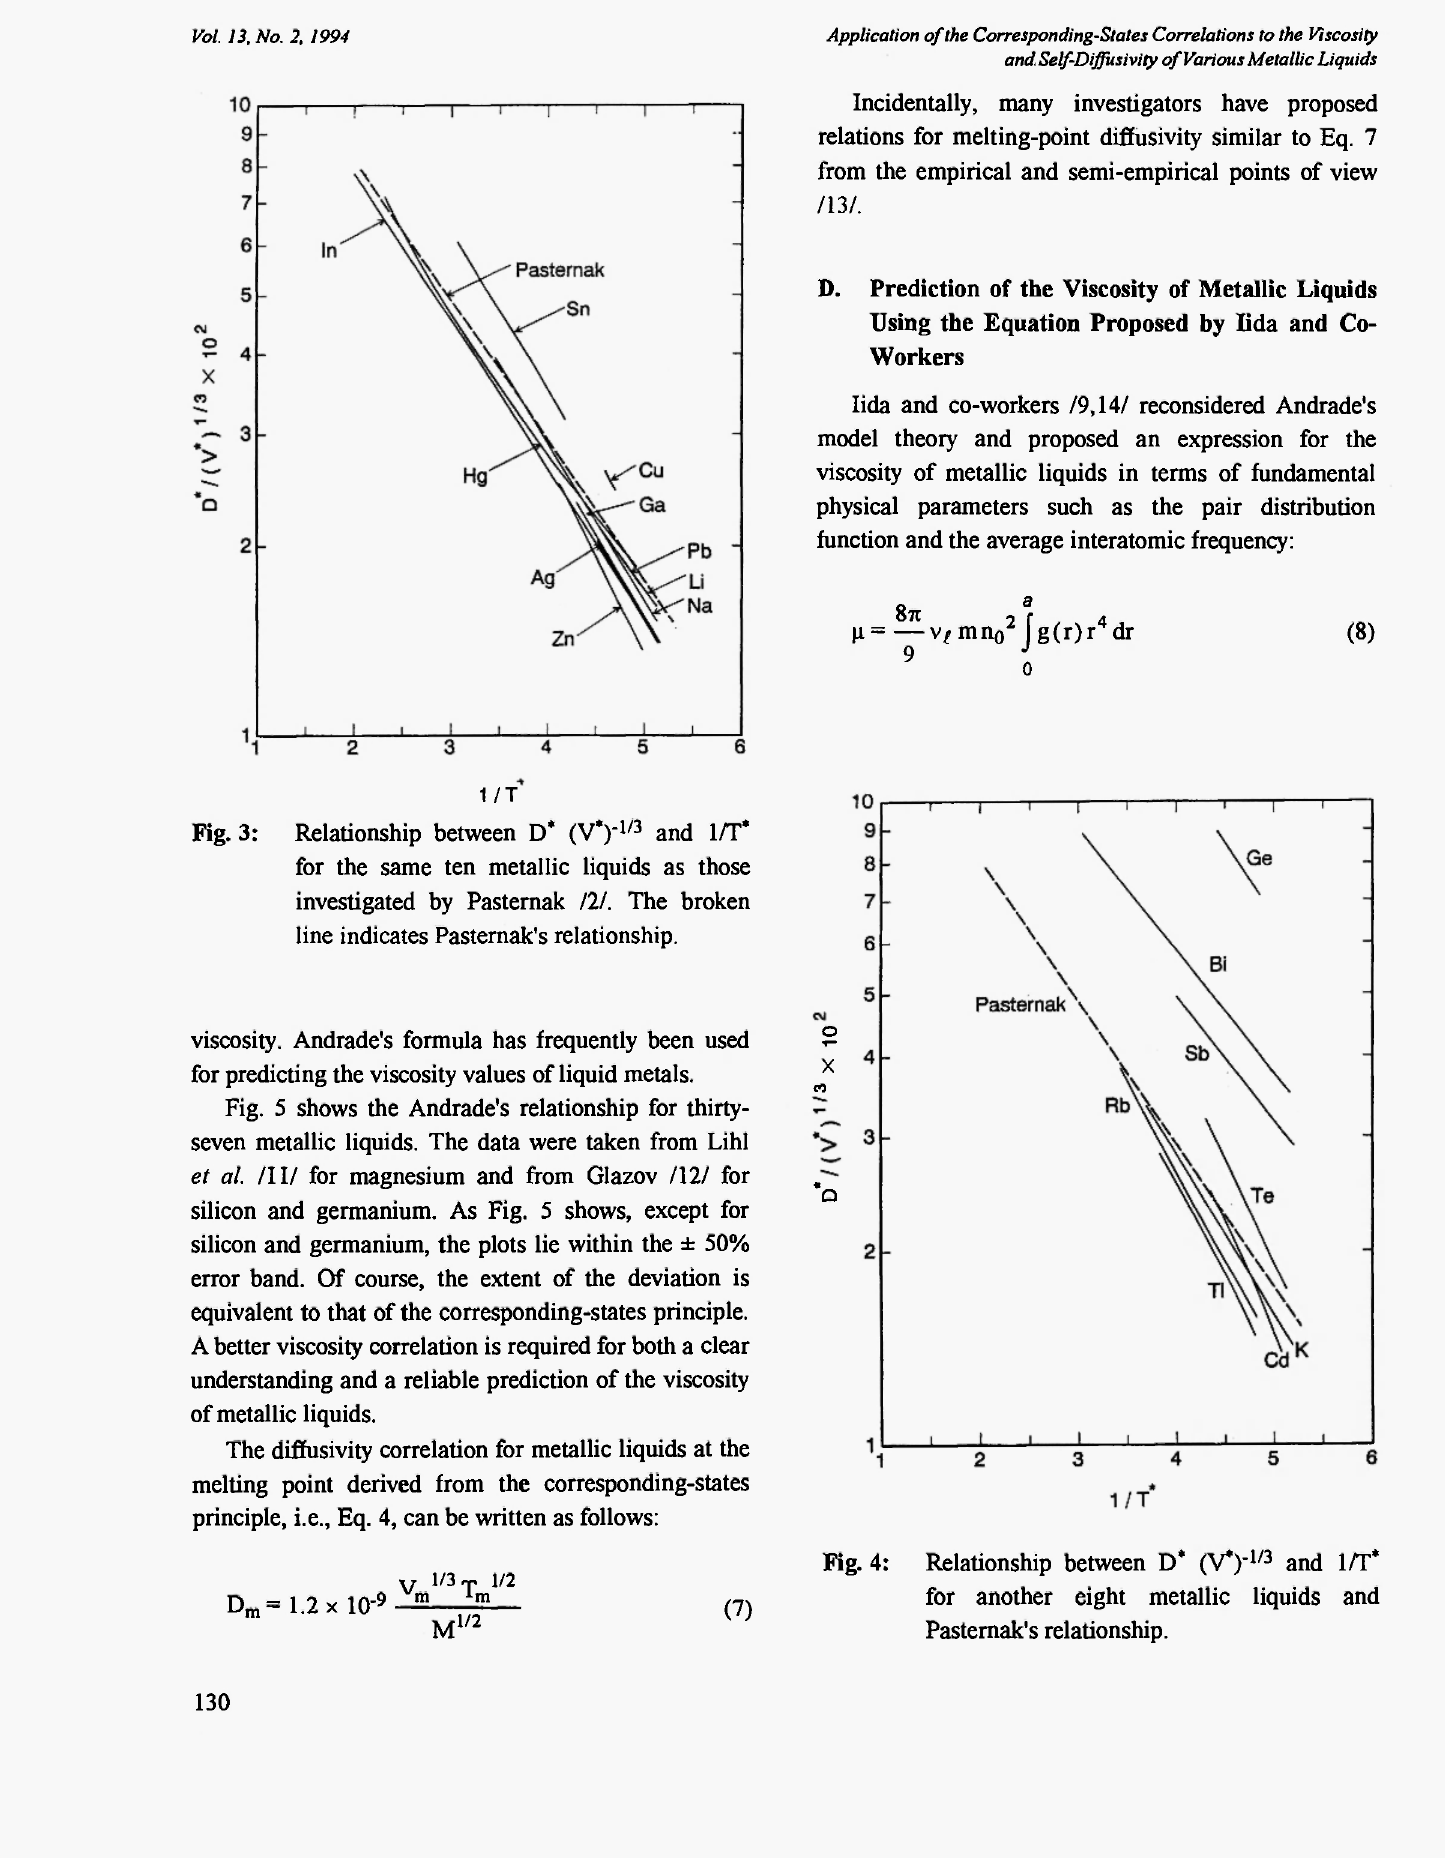
Fig. 3: Relationship between D* (V*)" 1/3 and 1/T* for the same ten metallic liquids as those investigated by Pasternak 111. The broken line indicates Pasternak's relationship.